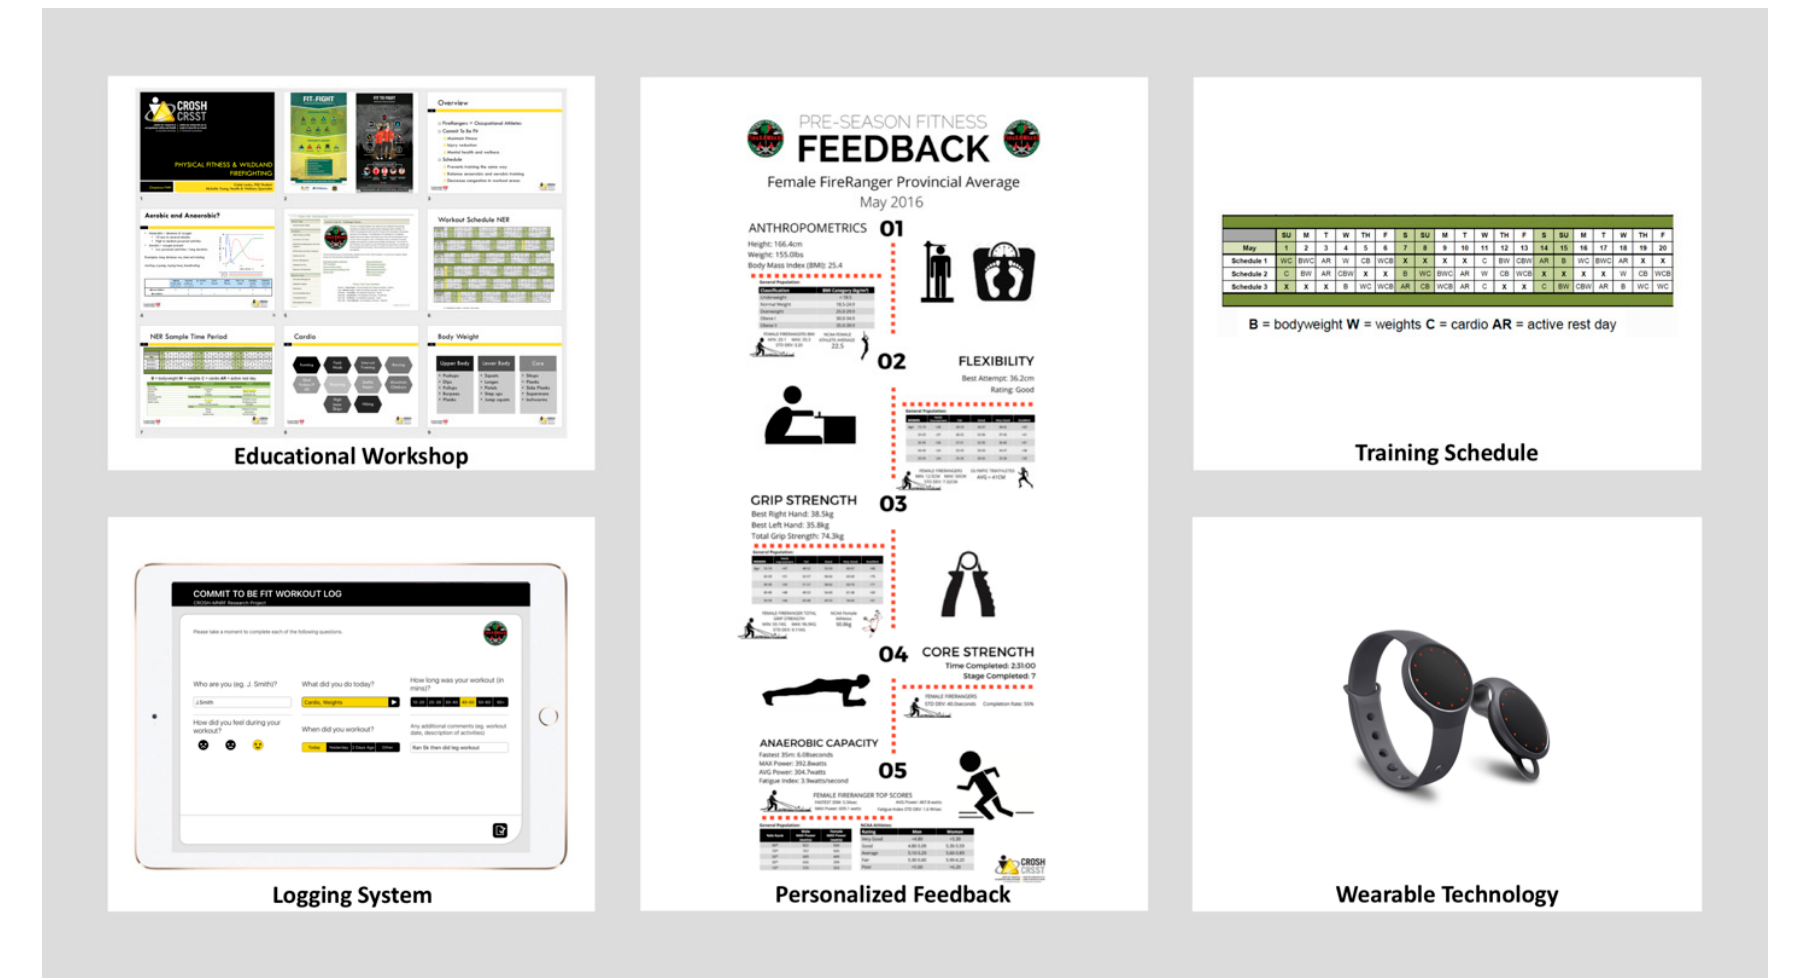
Figure 1. Fitness training intervention components.